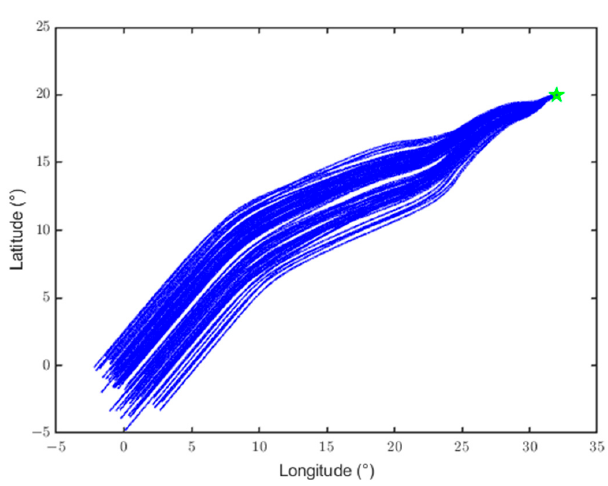
Figure 28. Latitude and longitude